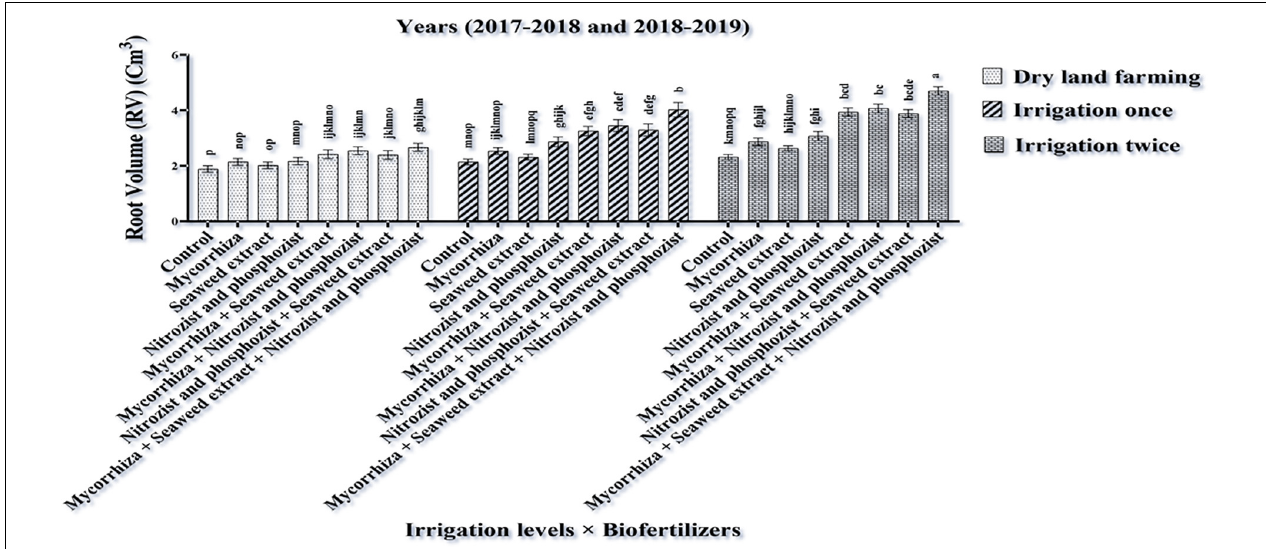
FIGURE 1 | Mean comparisons of the dual interaction effect of irrigation × biofertilizers on root volume trait of wheat plant in two seasons of experiment (2017–2018 and 2018–2019). Means in each column followed by similar letter(s) are not significantly different at 1% probability level by the LSD test.